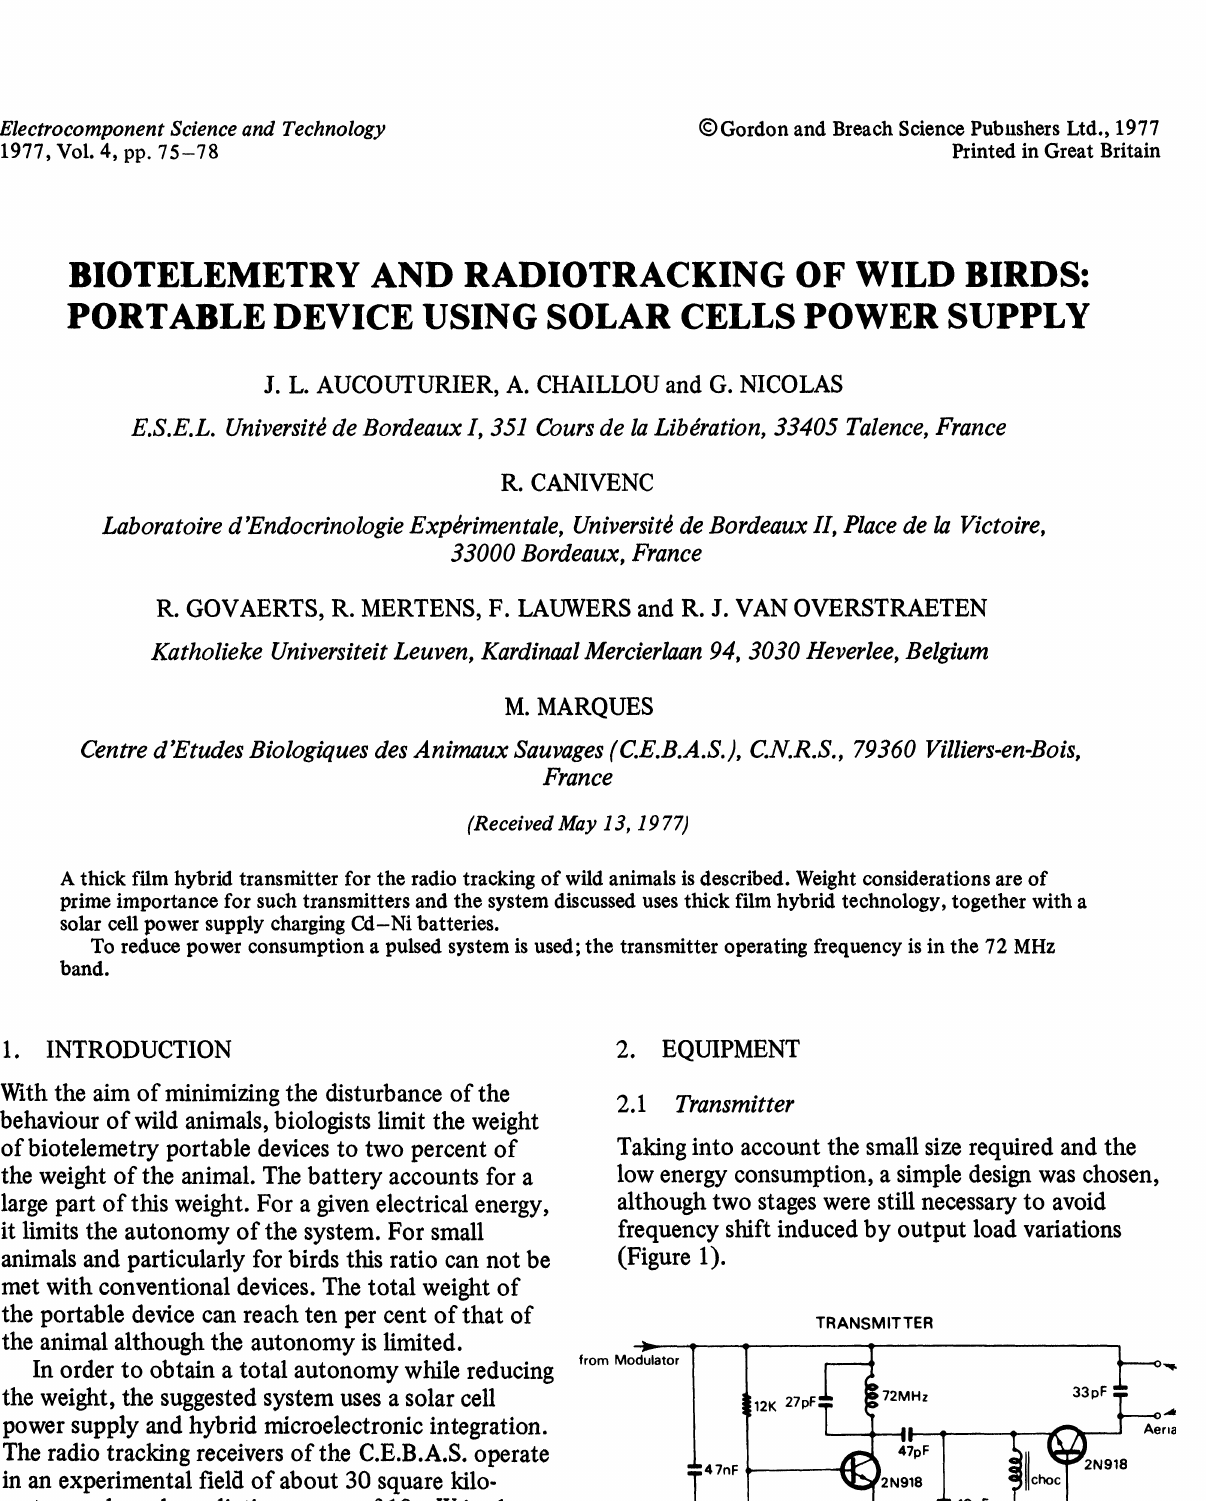
FIGURE Circuit diagram of